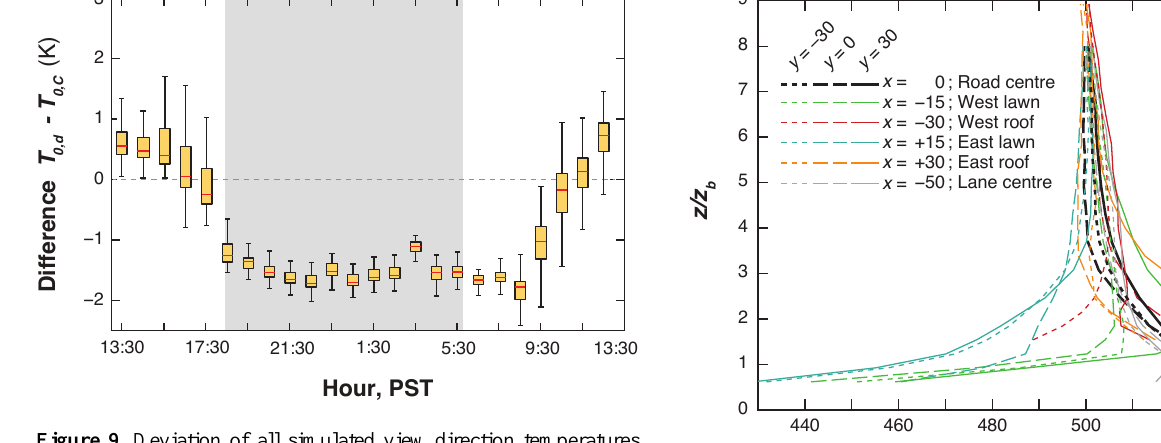
Figure 9. Deviation of all simulated view direction temperatures from T 0 , C by time step. The box plot show minimum, maxi- mum (whiskers), 5 and 95% percentiles (boxes) and median values (bars).